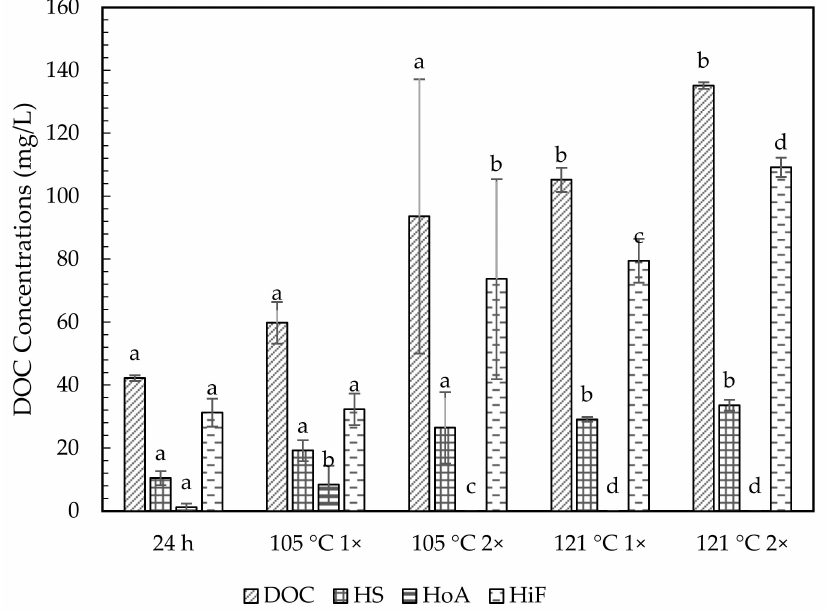
Figure 5. Fraction of dissolved organic matter for Kenyir soil extracts. DOM fractions are DOC, total dissolved organic carbon; HS, humic substances; HoA; hydrophobic neutral and HiF, hydrophilic fraction. Bars represent standard error with n = 3. Same letters on top of graph indicate no significance difference using one-way ANOVA ( p > 0.05) and Tukey post hoc. Comparison between